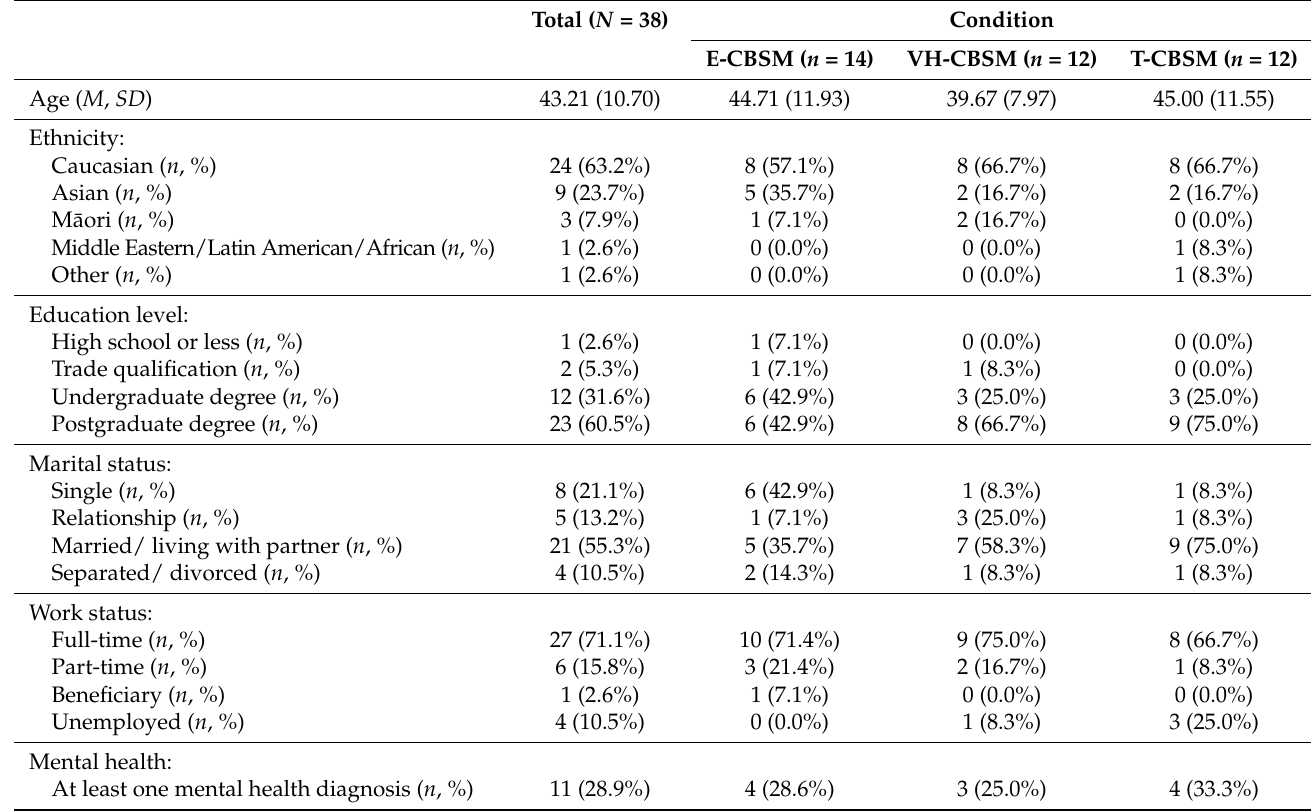
Table A1. Baseline demographic and psychological